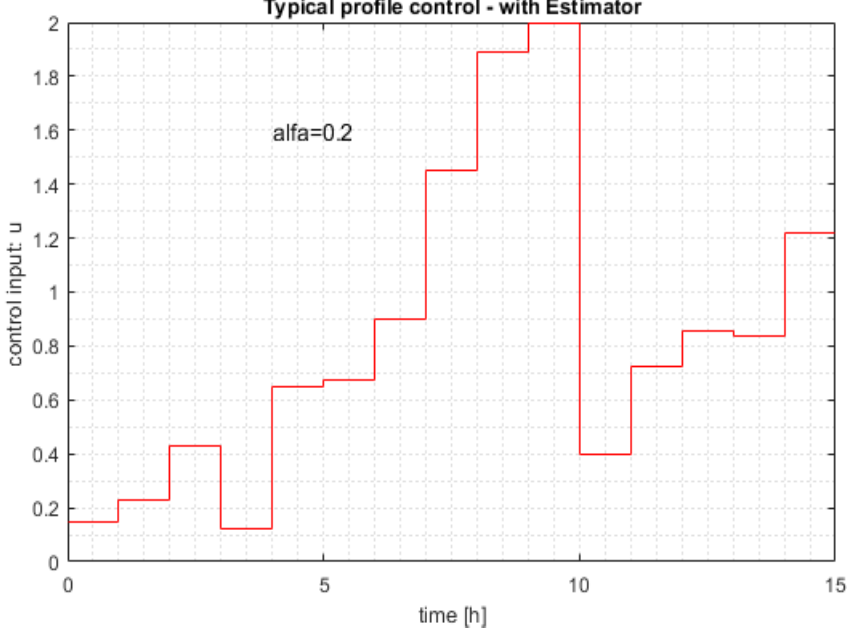
J min J avg J max Sdev J typical 31.666 31.880 32.067 0.00687 31.887